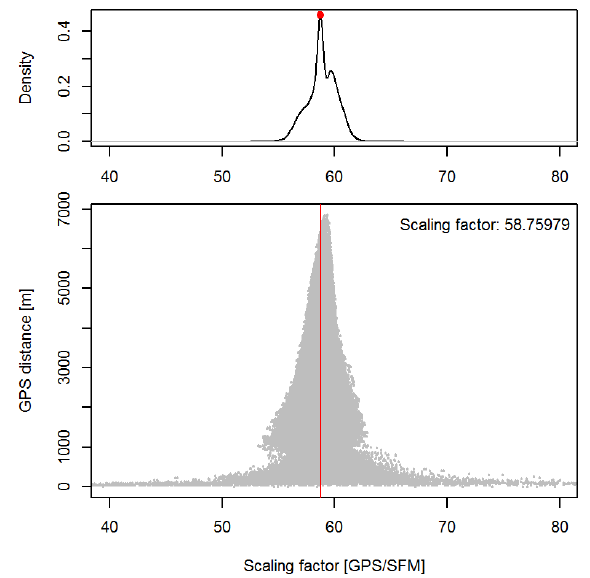
Figure 2 : Scale estimate between all possible point pairs. The figure showsthat points with short baselines should not be used to compute the scale (e.g. <500m). The relative length error coming from GPS location uncertainty is too large. Instead, when computing the density of scale distribution (upper panel) a consensus value is obtained. Scale was obtained by computing the highest density of the probability density function of the ratio between pairs of points in model and cartographic coordinates (Figure 2 upper panel). Figure 2 (lower panel) shows that when points were less than 500m apart, the scatter of scale estimate was very large and converges for baselines longer than 1km. Such scatter comes from the imprecise GPS position determination.